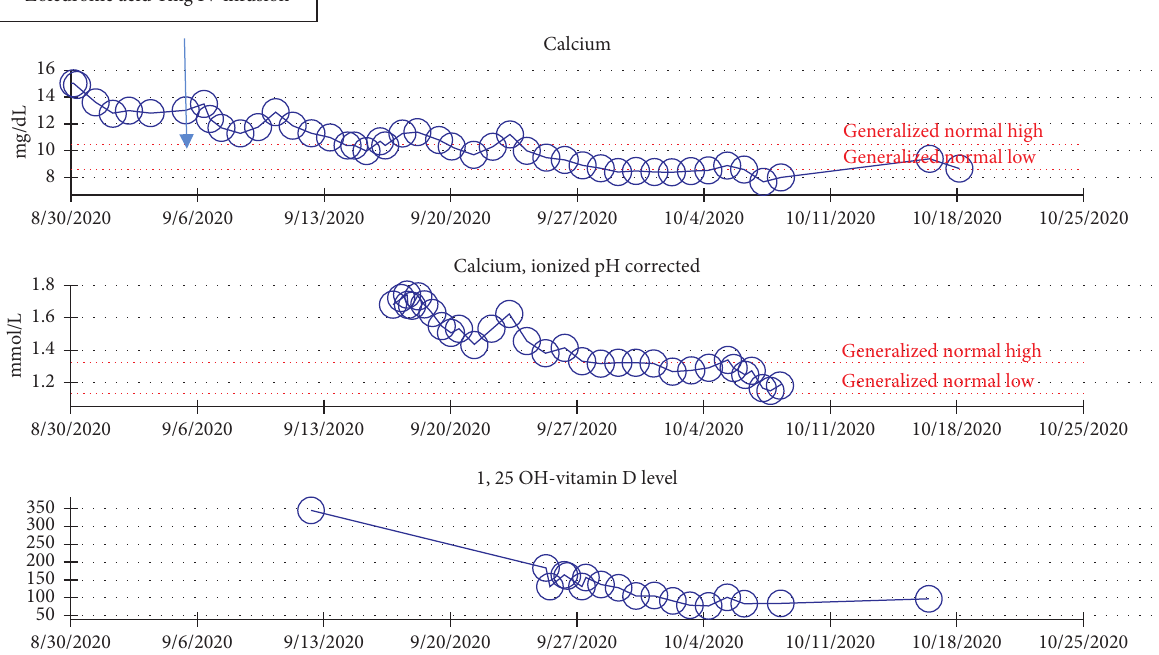
Figure 1: Trends of total serum calcium, ionized calcium, and 1,25-dihydroxyvitamin D levels during hospitalization.